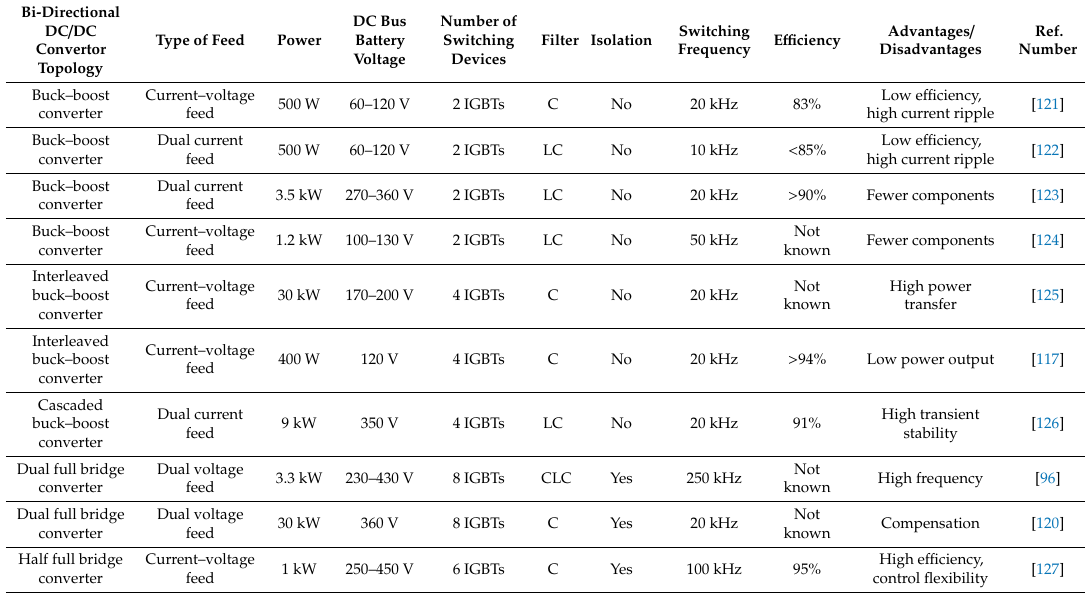
Table 3. Comparison of bi-directional DC / DC converter topologies for V2G applications in the literature. Bi-Directional DC / DC